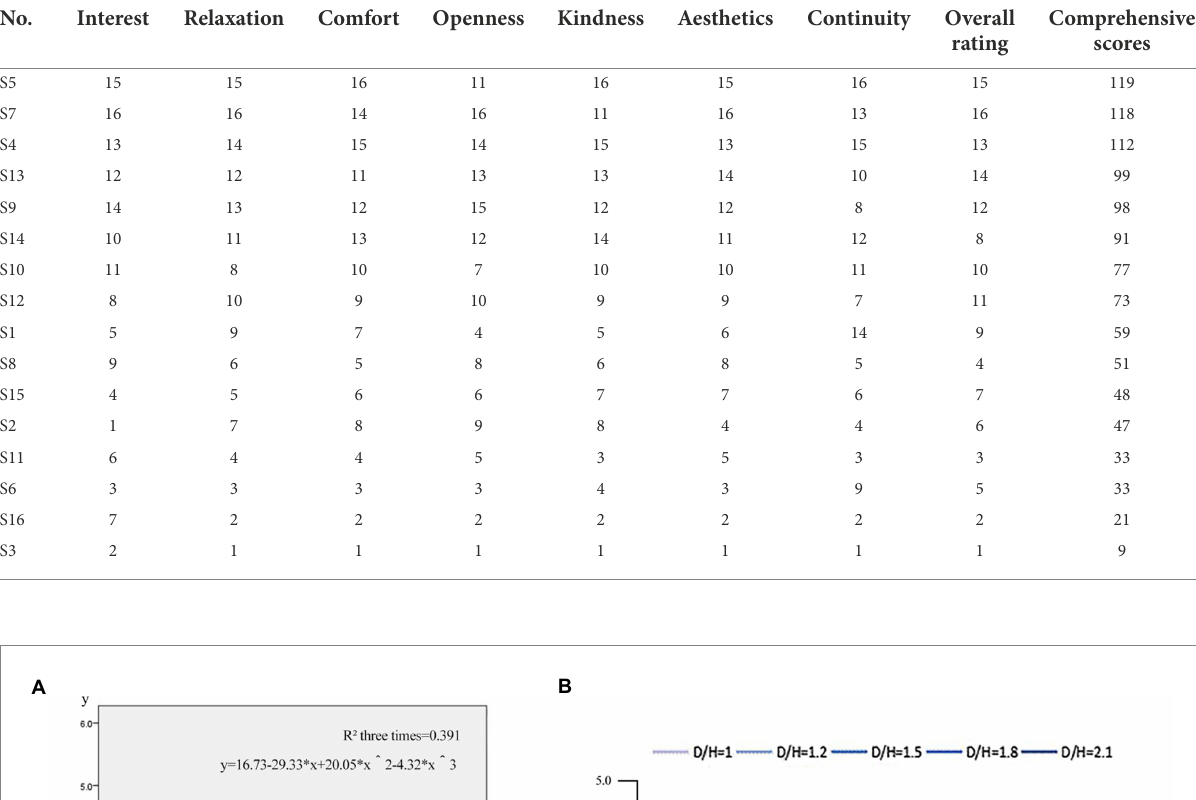
TABLE 9 Scene classification index and comprehensive scores.